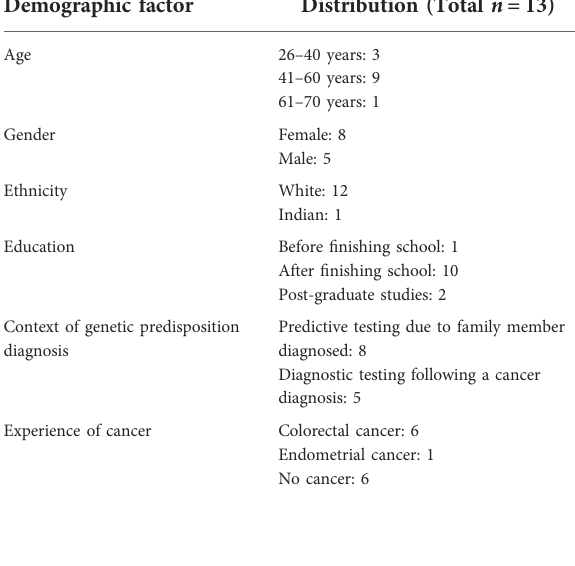
TABLE 1 Demographics and clinical information for the public involvement contributors ( n